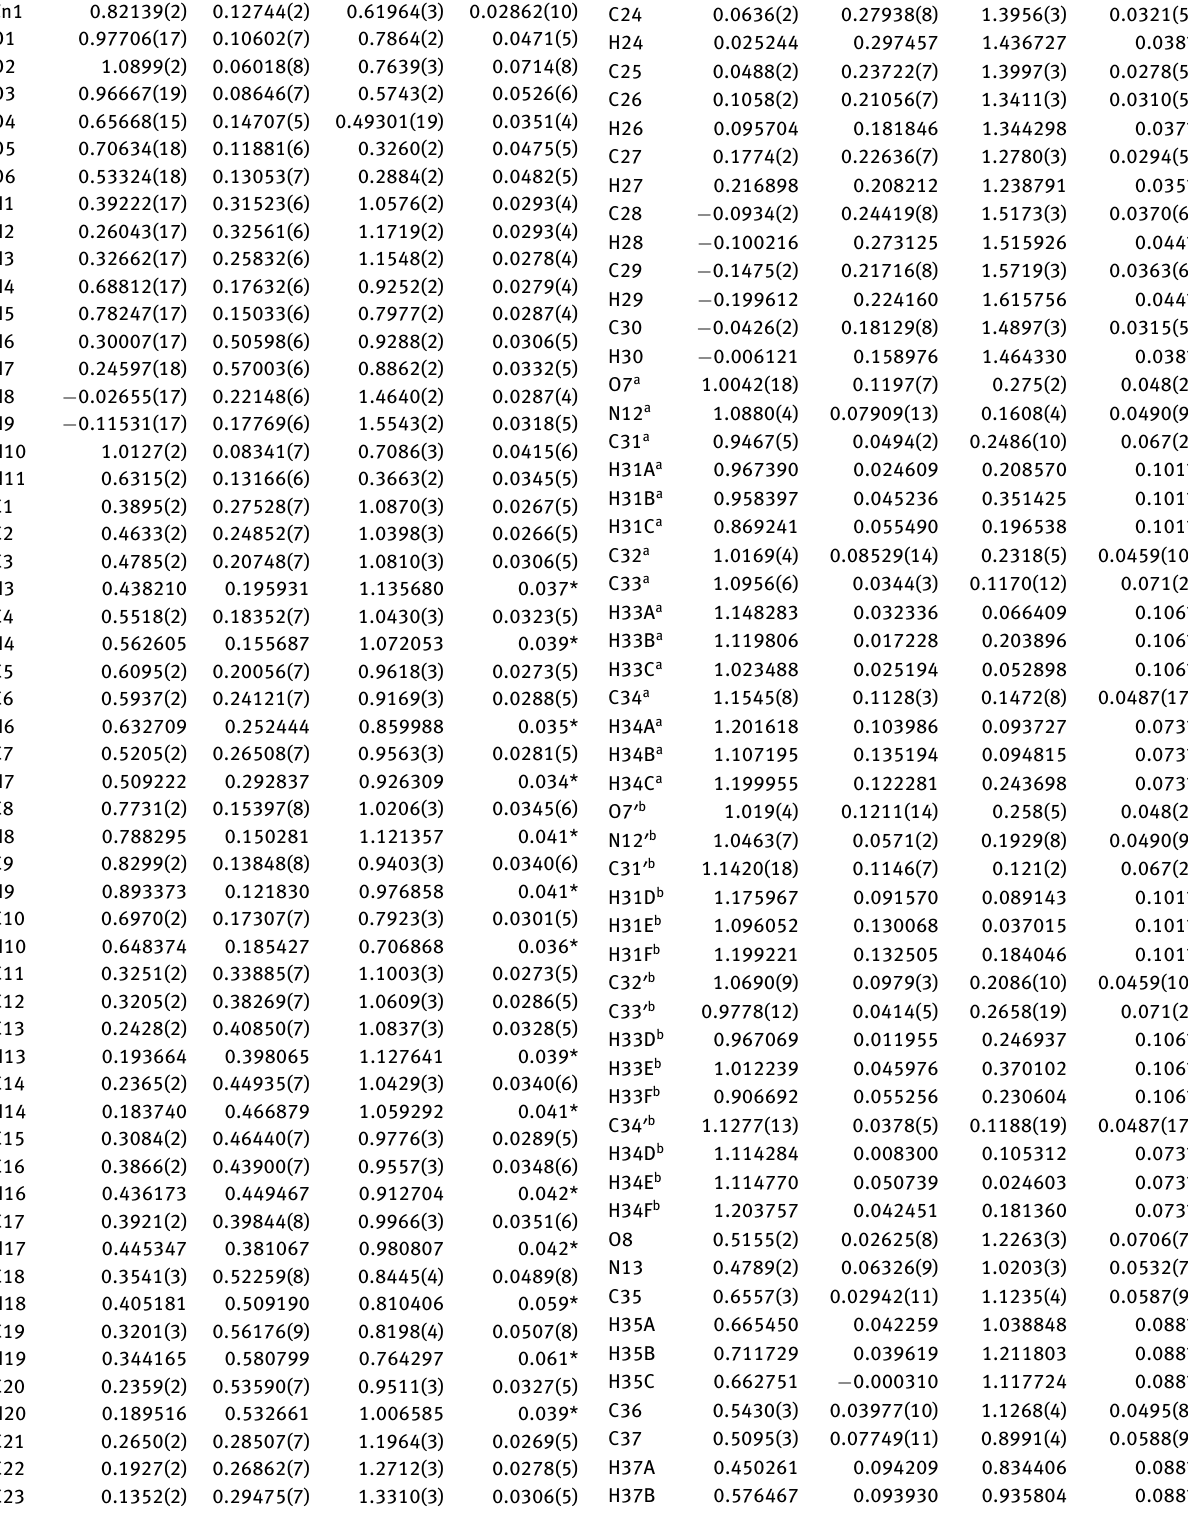
Table 2: Fractional atomic coordinates and isotropic or equivalent isotropic displacement parameters (Å 2